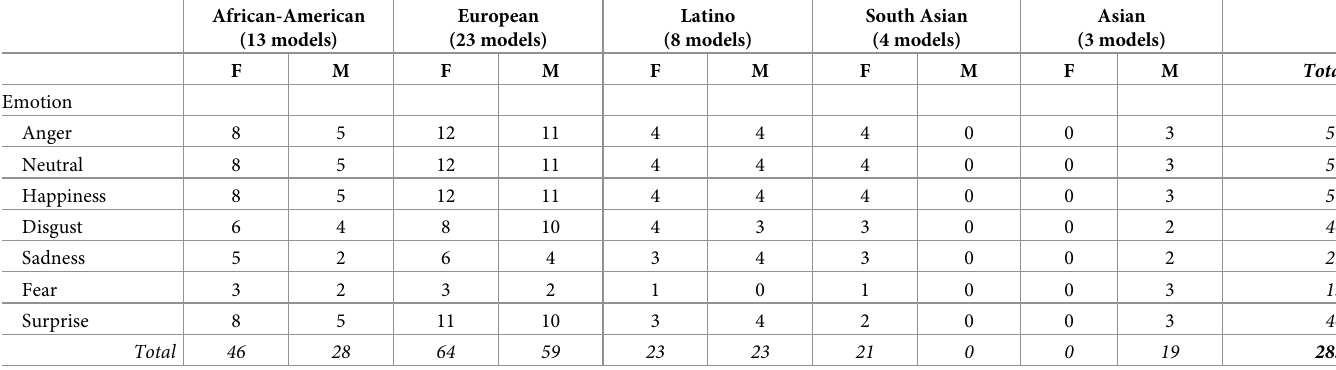
Table 2. Number of photographs for each emotional expression according to model’s race/ethnicity and model’s sex. African-American (13